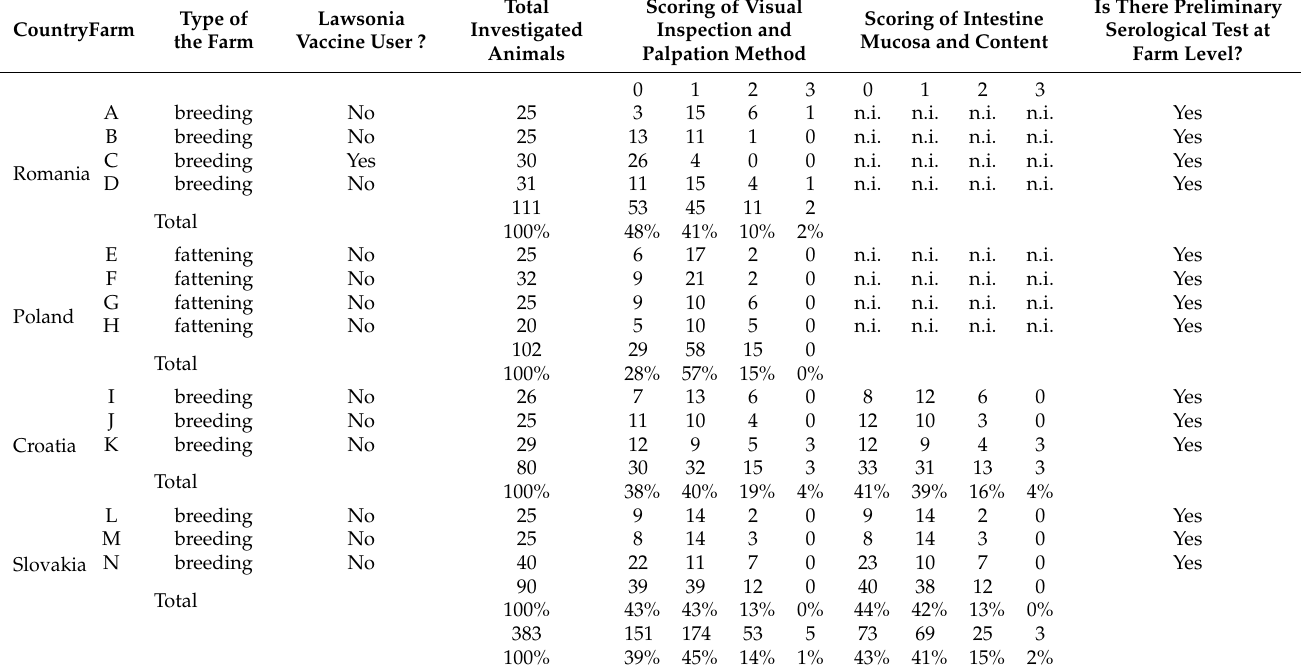
Table 2. VP versus mucosa in RO, PL, CR,